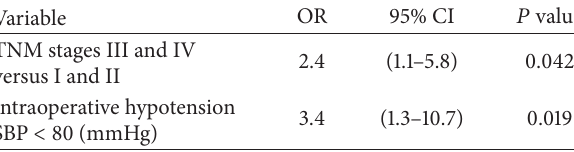
Table 2: Perioperative/operative variables. Table 3: Multivariate analysis of risk factors for incisional